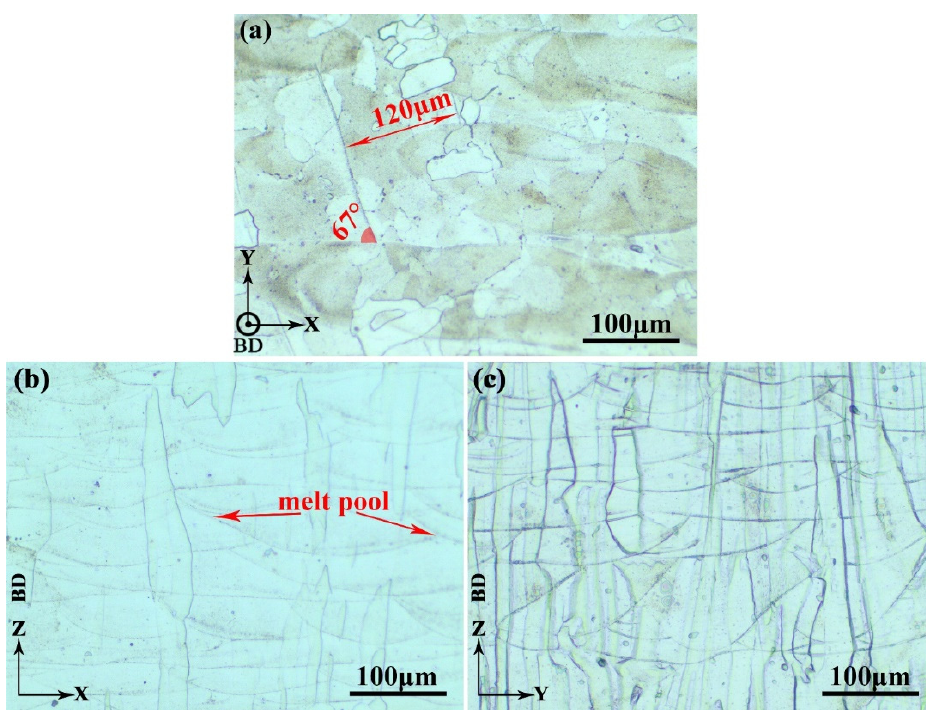
Figure 7. The OM images showing typical microstructures of sample X in the ( a ) XY-, ( b ) XZ-, and ( c ) YZ-planes. BD represents the build direction.